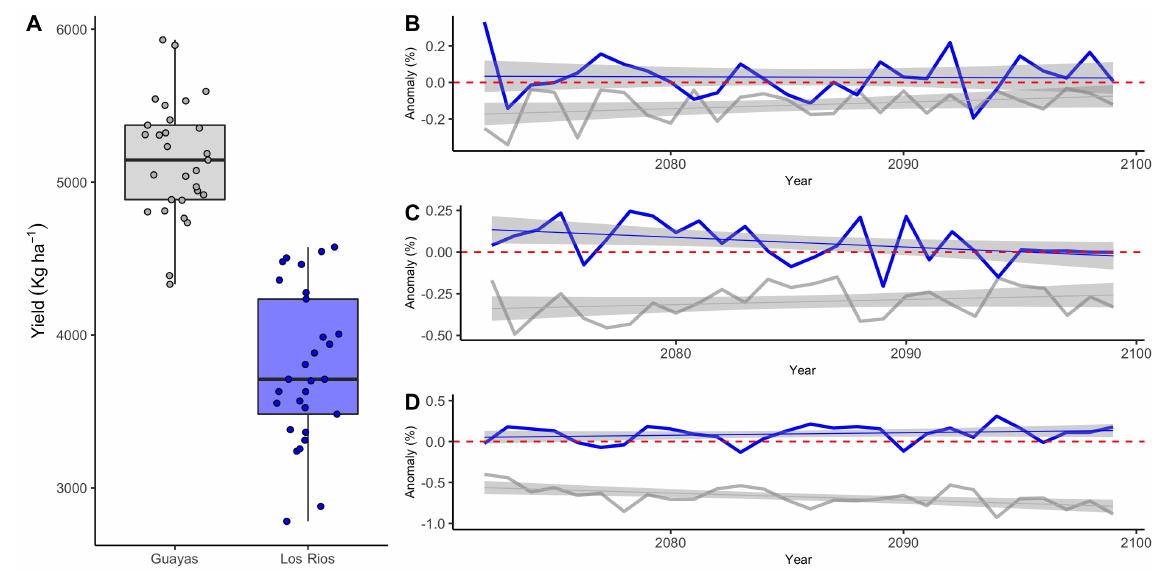
Figure 5. Percent change in rice yields estimated from the RegCM4 RP VSM output ( A ) for the Provinces of Guayas (gray) and Los Ríos (blue) with corresponding changes over the time pe- riod under RCP 2.6 ( B ), RCP 4.5 ( C ), and RCP 8.5 ( D ) as related to the yields of the base period (1975–2005). The lines represent changes in yield over time. Grey shaded areas in ( B – D ) represent 95% prediction confidence. Table 2. Percentage yield, harvest day, and biomass change with respect to RP (1975–2005). Yield Harvest Day Biomass Guayas * − 0.3658 − 0.1902 − 0.3014 RCP 2.6 − 0.1236 − 0.0765 − 0.1168 RCP 4.5 − 0.2982 − 0.1477 − 0.2494 RCP 8.5 − 0.6756 − 0.3463 − 0.5380 Los Rios * +0.0598 − 0.0773 +0.0131 RCP 2.6